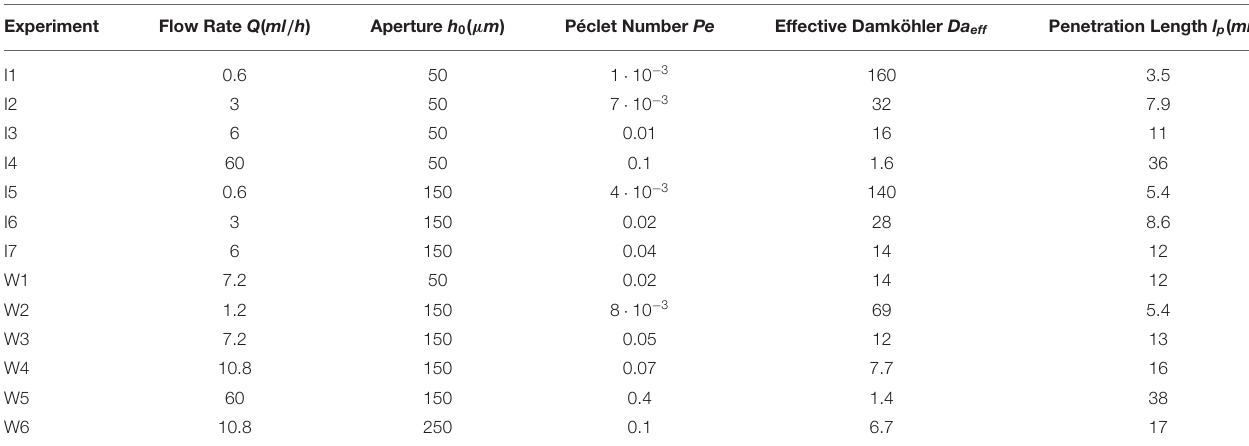
TABLE 1 | Experimental